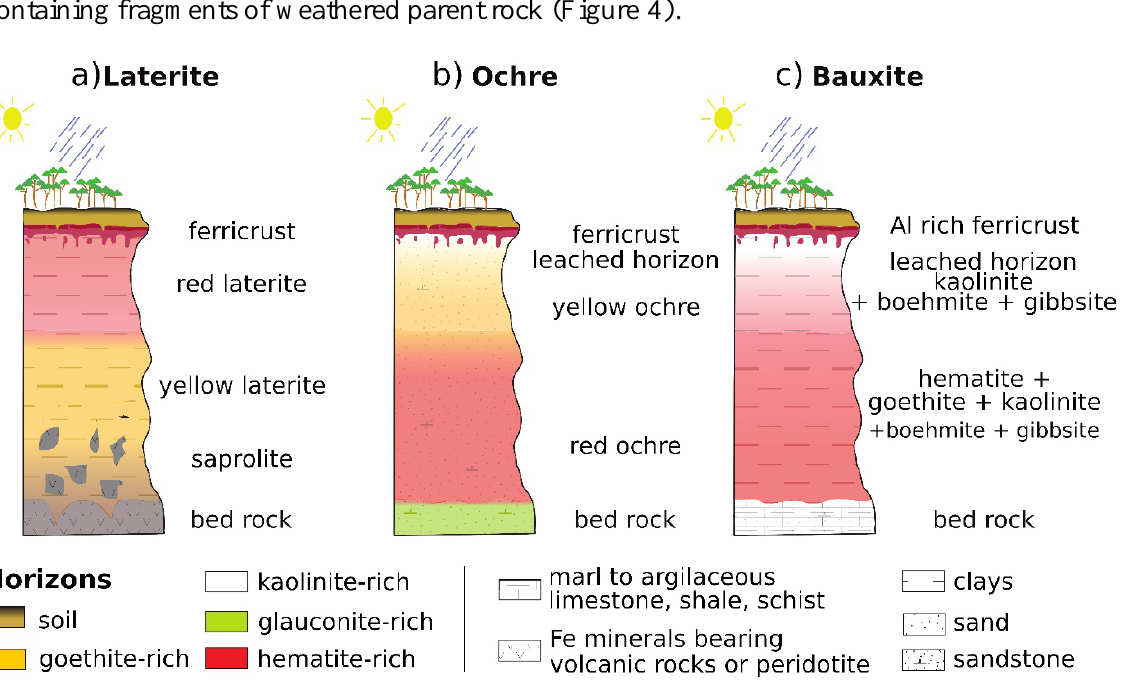
Figure 4. Weathering profiles: a) Laterite, b) Ochre, c) Bauxite. Diagrams: A. Chassin de Kergommeaux (after Coquinot & Salomon (2013); Triat 2010: 117, 123, 125, 127, 134 and